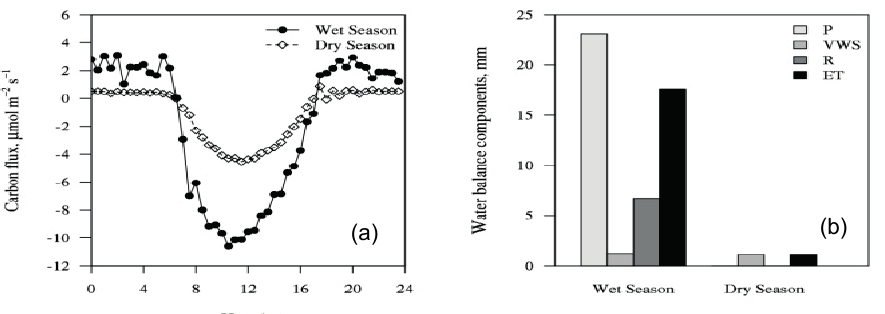
Fig. 5 (a) daily flow of CO 2 in the wet and dry seasons; (b) water balance components in the wet and dry seasons in grassland.